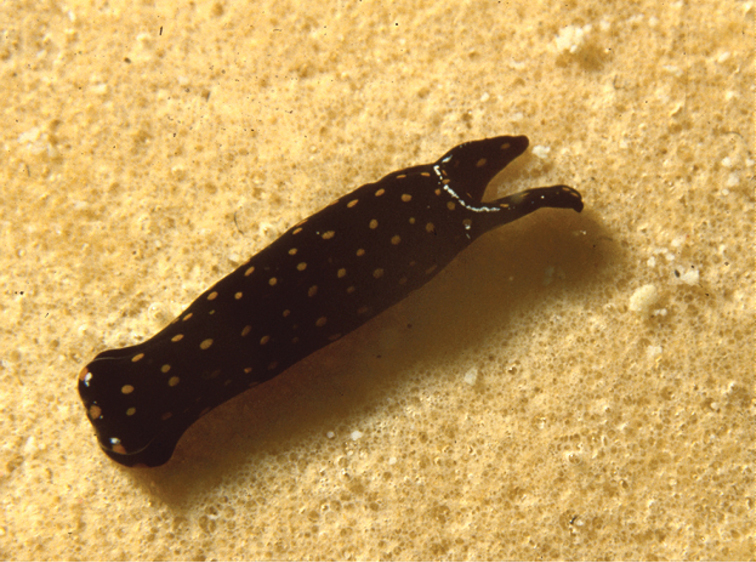
Chelidonura cf. punctata, Seychelles, photo: P Kemp (no spcm).